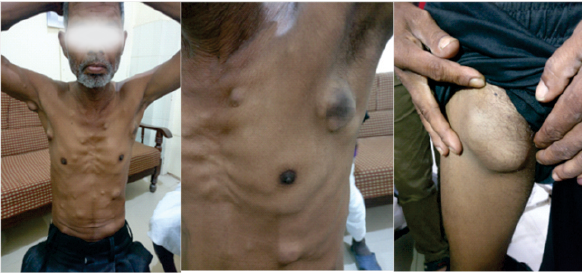
Figure: Multiple nodules of varying sizes in trunk, abdomen (1), bilateral axilla (2) and inguinal region (3) Fine needle aspiration cytology from a nodule on the back revealed a highly cellular smear with markedly dispersed cells with variable aniso- karyosis and pleomorphism; individual cells with well-dened irregular cell membrane, abundant cytoplasm and frequent predominant large presence of macromolecule and binucleate cells [Panel A]. An excision biopsy from a nodule in right arm demonstrated the skin and subcutaneous tissues with atypical cells arranged in diffuse sheets and nests inltrating into the dermis [panel B] ; indiv- idual cells having round to spindle shape, displa- ying moderate pleomorphism, vesicular chroma- tins and prominent nucleoli [panel C]. Occasional atypical mitosis with extracellular melanin pigment deposition seen [panel D].